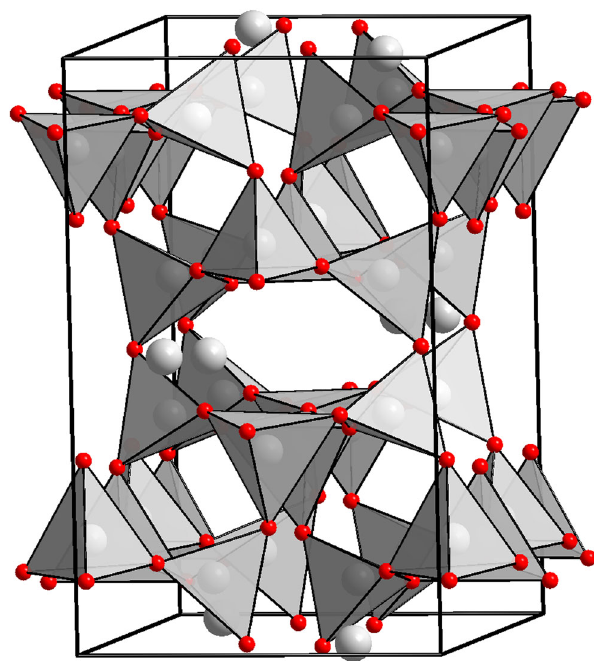
Fig. 1 Feldspar crystal structure under ambient conditions. All Si and Al atoms are bonded to four oxygen atoms to form tetrahedra. SiO 4 and AlO 4 tetrahedra (given in grey) form a three-dimensional framework by sharing common vertices. Al atoms occupy half of the tetrahedral sites in anorthite (CaSi 2 Al 2 O 8 ) and a quarter of the sites in albite (NaAlSi 3 O 8 ) and microcline (KAlSi 3 O 8 ). Large cations (Ca 2 + , Na + , K + ) located in the framework voids are represented grey spheres. Oxygen atoms are given in red. Black lines outline the unit cell of the aristotype